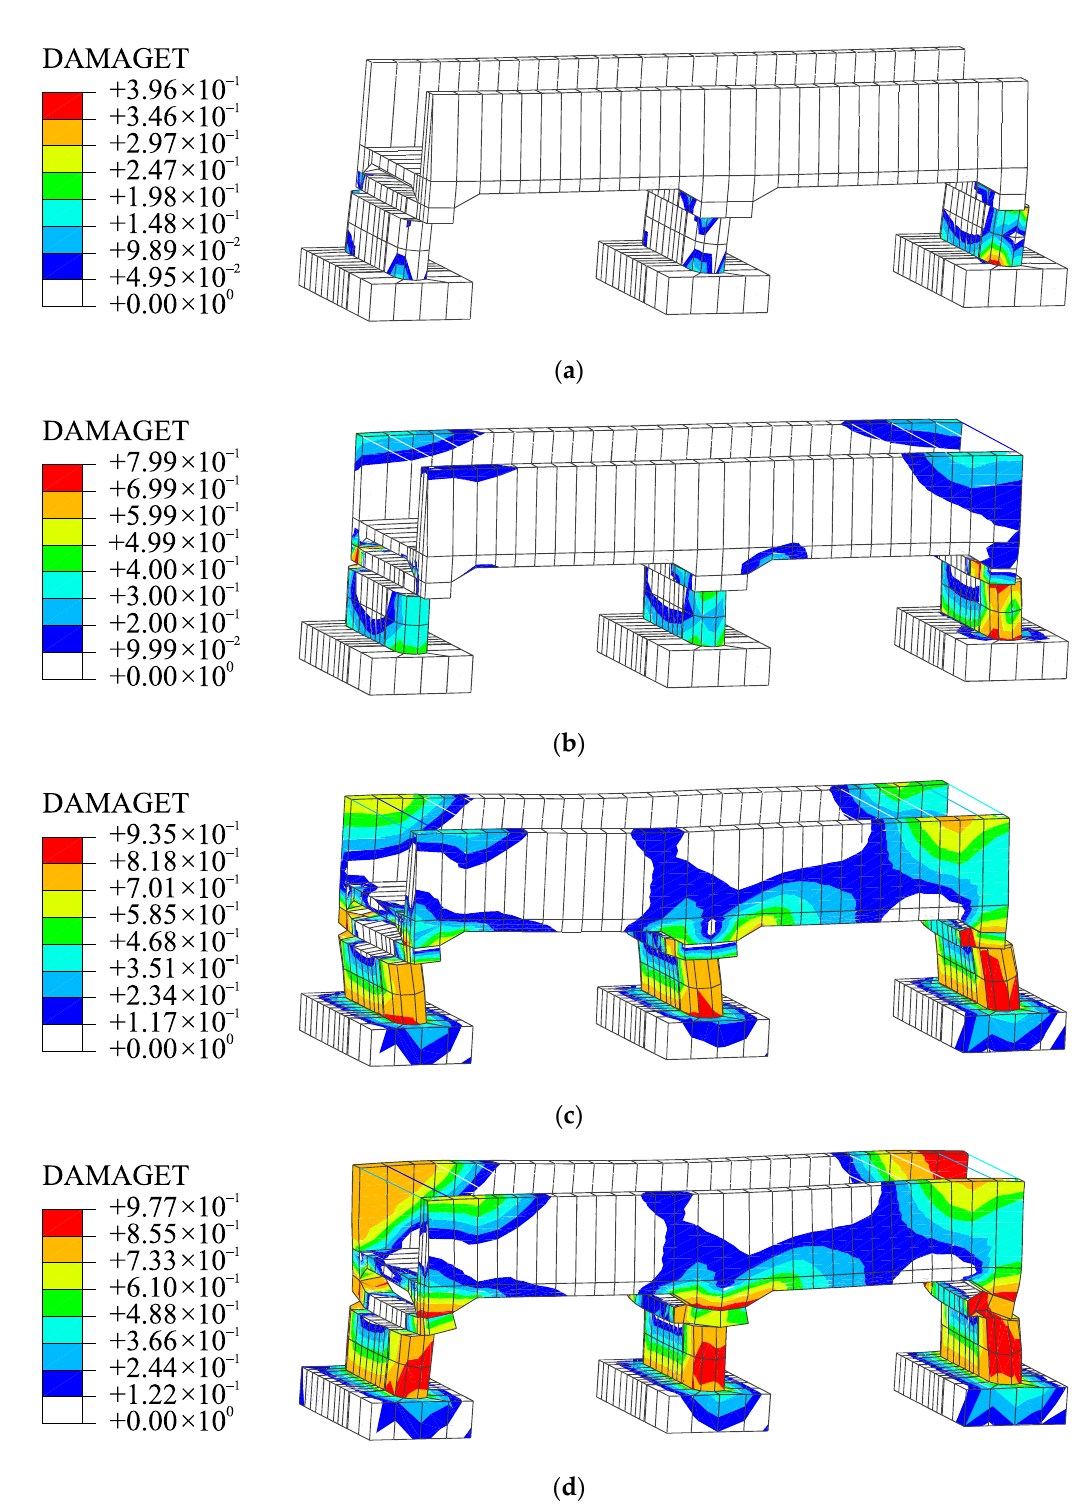
Figure 4. Developing process of aqueduct’s damage process under rare earthquake. ( a ) t = 4.22 s; ( b ) t = 8.20 s; ( c ) t = 10.44 s; ( d ) t = 25.00 s.